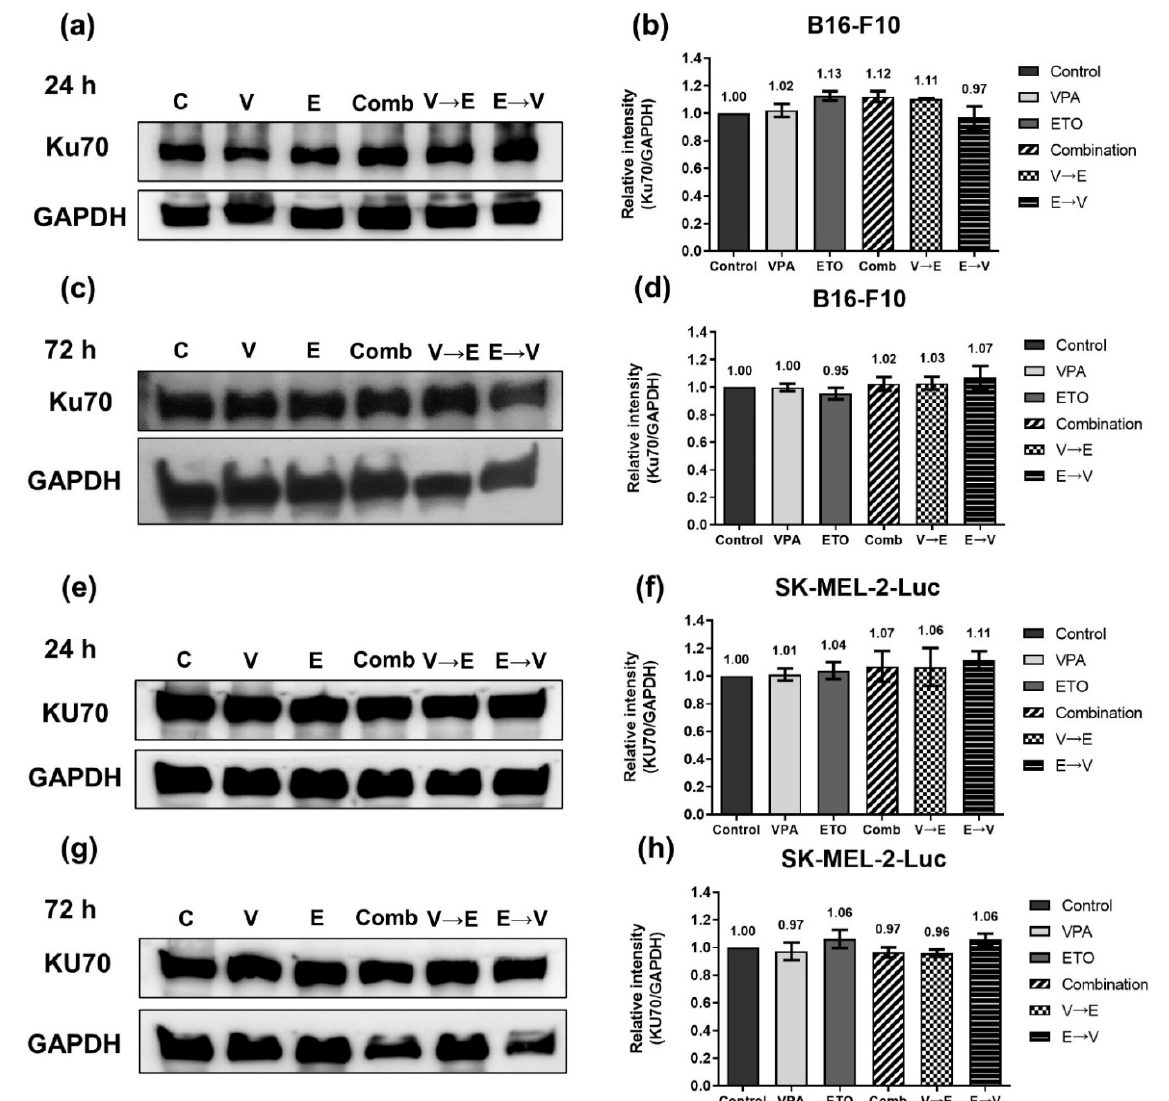
Figure 10. Expression of non-homologous end joining (NHEJ) related protein Ku70/KU70, under single, simultaneous, and sequential combined treatments of VPA and ETO in melanoma cells. Western blot analysis illustrated the Ku70/KU70 protein expression after ( a ) 24 h ( c ) 72 h single, simultaneous, and sequential combined treatments of VPA and ETO in B16-F10 cells. ( b , d ) was quantitative analysis of ( a , c ), respectively, which was obtained by using Image J software 1.52a (National Institutes of Health, Bethesda, MD, USA). The analysis was repeated in SK-MEL-2-Luc cells. Western blot data of ( e ) 24 h and ( g ) 72 h was shown, and the corresponding quantitative analysis was shown in ( f , h ), respectively. GAPDH was used as the control of sample loading. Relative intensities of Ku70/KU70 to GAPDH expressions were normalized with the control. The data are shown as means ± SEM of independent experiments in triplicate. The drug dosages were referred to IC 50 values as shown in Figure 2 and Table 1.